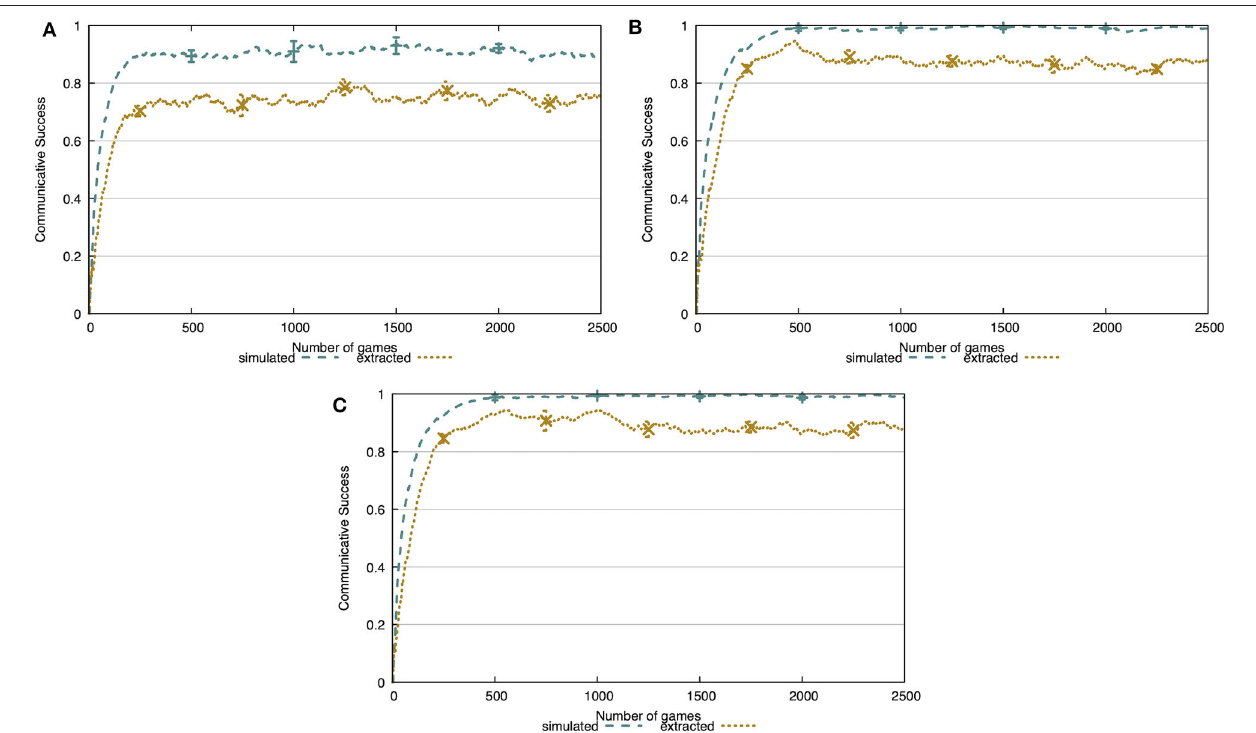
FIGURE 8 | Communicative success after learning for 100 interactions (A) , 500 interactions (B) , or 1,000 interactions (C) in condition A. The concepts are learned completely independently from the co-occurrences in the environment. The agents achieve the same level of communicative success as in the previous experiment, given at least 500 interactions in condition